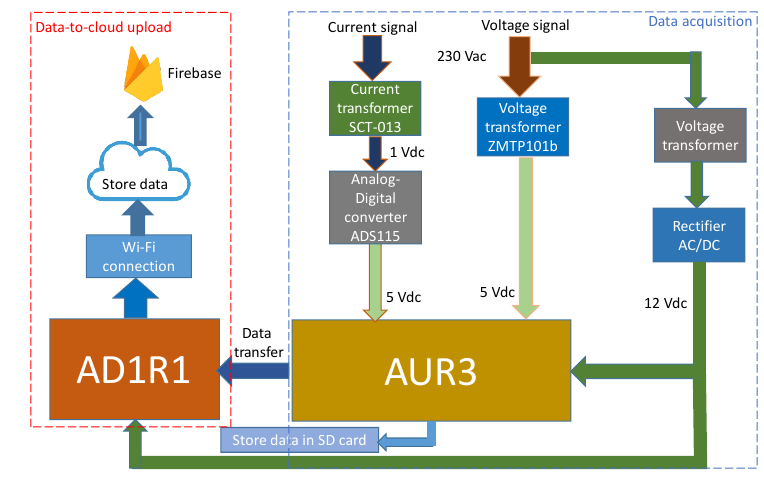
Figure 3. Block diagram for the data acquisition and uploading.